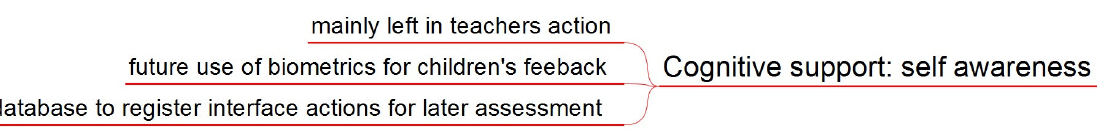
Figure 4. Services requirements for cognitive support in self-awareness.